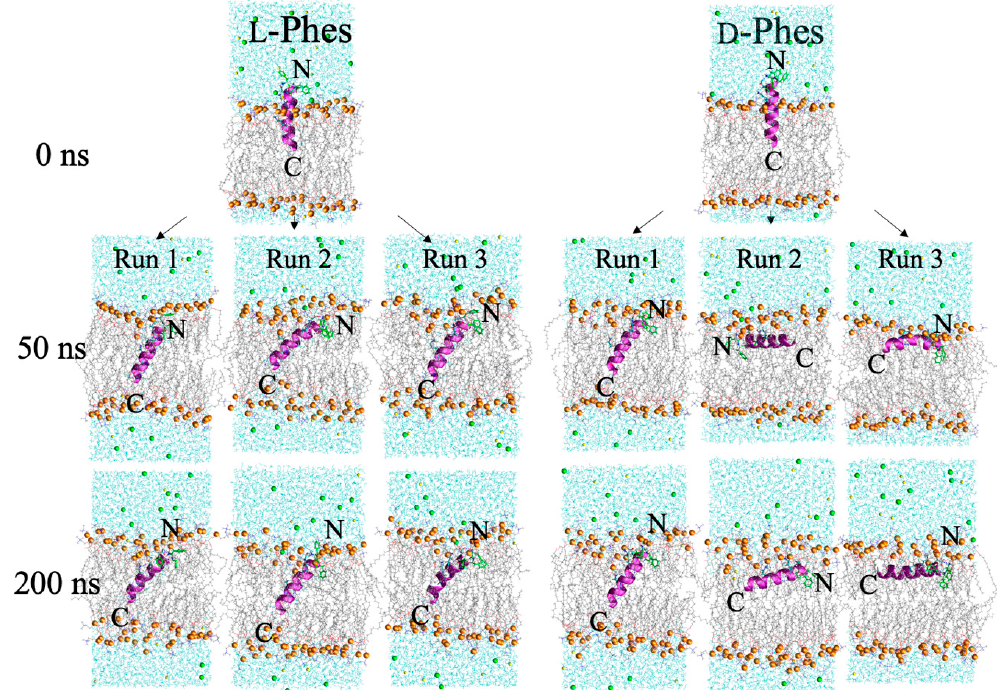
Figure 5. The last snapshots of the third type of simulations of L- (left) and D-Phes (right). Water molecules and ions were omitted for the clarity. Charged and three-phenylalanine residues are shown by licorice model. Orange balls show phosphorus atoms of DMPC membrane. Green and yellow balls represent the sodium and chloride ions, respectively.